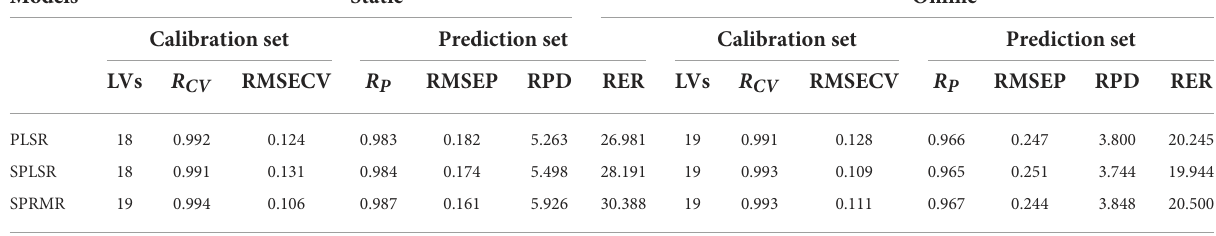
TABLE 3 Quantitative analysis results of snow peach SSC with PLSR, SPLSR and SPRMR modeling methods.